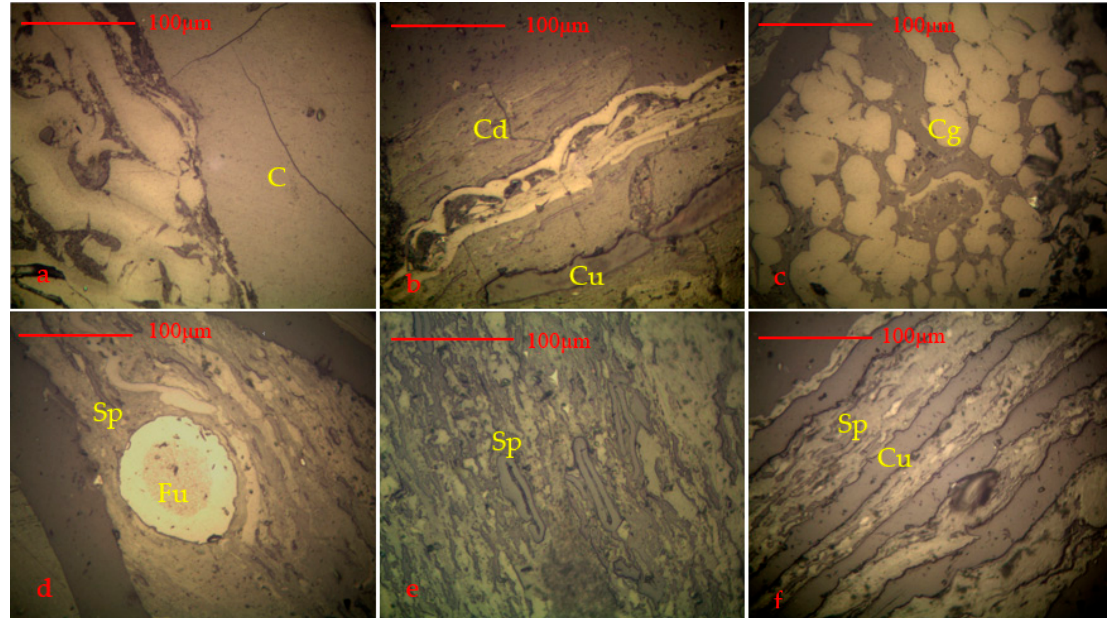
Figure 4. Vitrinite and liptinite in the Jungar coal under an optical microscope with reflected white light and immersed in oil immersion: ( a ) collotelinite (C), sample 4-2, ( b ) collodetrinite (Cd), sample 6-2, ( c ) corpogelinite (Cg), sample 6-10, ( d ) funginite (Fu), and sporinite (Sp), sample 4-3, ( e ) sporinite (Sp), sample 6-3, ( f ) cutinite (Cu) and some liptinite macerals in sample 6-10.